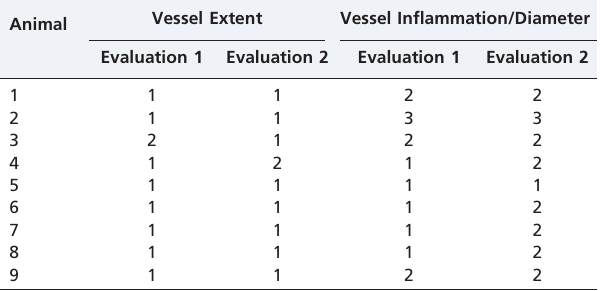
Table 2 - Blinded photographic analysis of vessel extent and inflammation/diameter in the study group, fourteen days after the corneal burn.